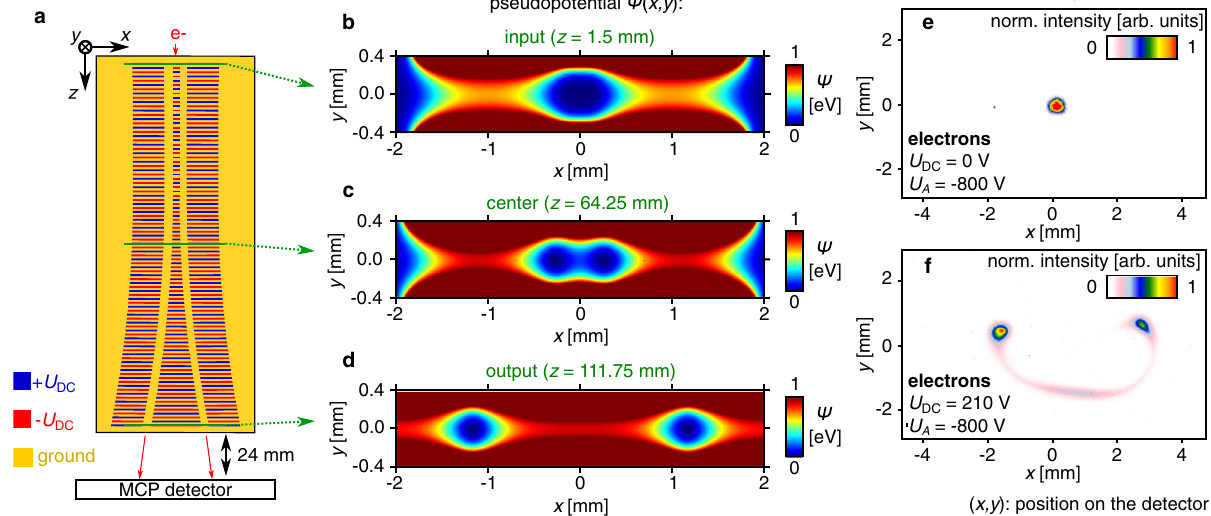
Fig. 4 Auto-ponderomotive beam splitting on chip. a Top view of the beam splitter chip. The layout consists of three rows of electrodes. The width of the central electrodes widens along the chip from 0.3 to 2.2 mm (not to scale for illustration, see the Supplementary Fig. 3 for a picture of the chip). Like the S- curved guide, the splitter consists of two chips facing each other with a separation of 1 mm. The upper chip 2 has the same electrode layout, but with inverted polarity. The electrode layout is chosen such that the minimum of the ponderomotive potential is continuously split into two minima separated by 2.3 mm at the chip end. To illustrate this splitting, we plot the simulated pseudopotential for an electron beam with U A = 800 V and U DC = 210 V in the transverse xy -plane at z = 1.5 mm at the input b , at z = 64.25 mm c , and at z = 111.25 mm at the output d . Clearly, the initially single central minimum splits continuously into two central minima as the particle propagates down the structure. e Detector image of an unguided electron beam ( U DC = 0 V). f Detector image of a split electron beam ( U DC = 210 V). Two spots are visible with a faint signal of lost electrons in between. The spot distance of 4.2 mm is expected given the opening angle of the split isopotential channels and the detector distance of 2.4